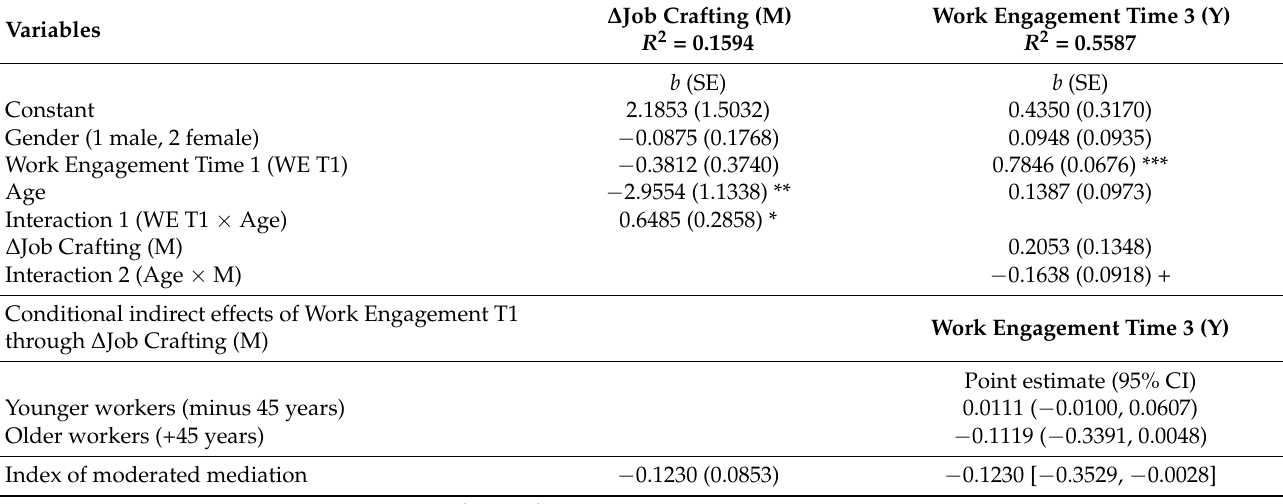
Table 2. Direct and indirect effects of the